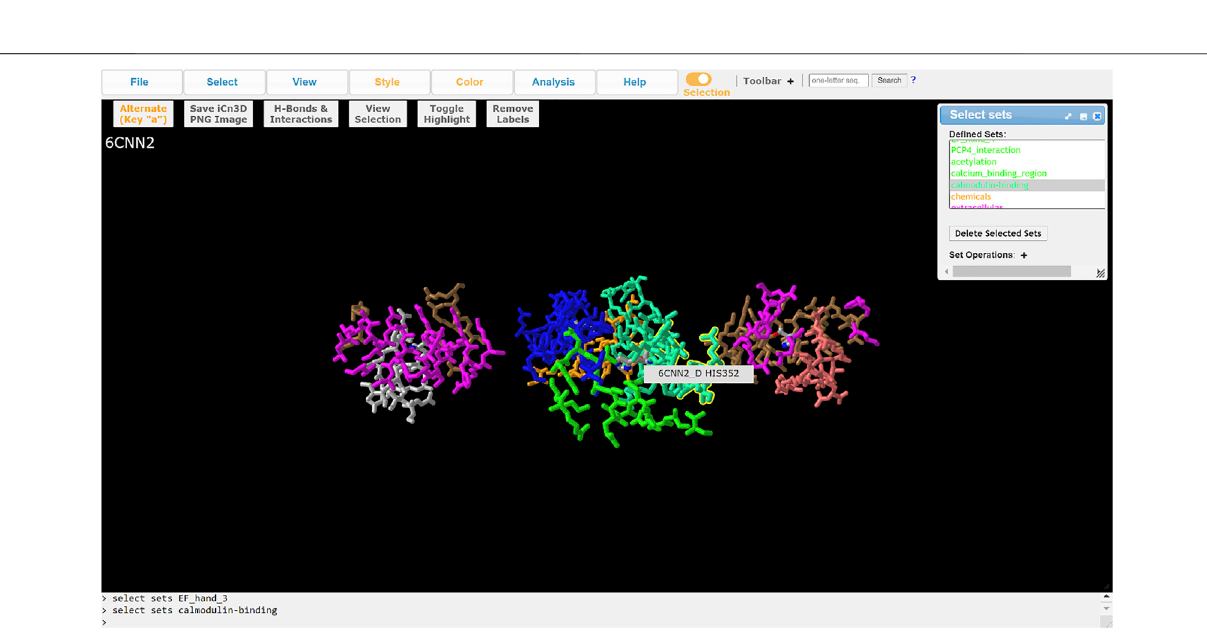
FIGURE3| VisualizationoftheSK4calcium-activated potassiumchannel(PDBID:6CNN)iniCn3DwithChanFADannotationandtheR352Hmutationintroduced using scap. R352H is in the calmodulin interaction domain, which is responsible for calcium binding and channel opening. The fi gure only shows the four calmodulin binding domains (one for each protein subunit) for